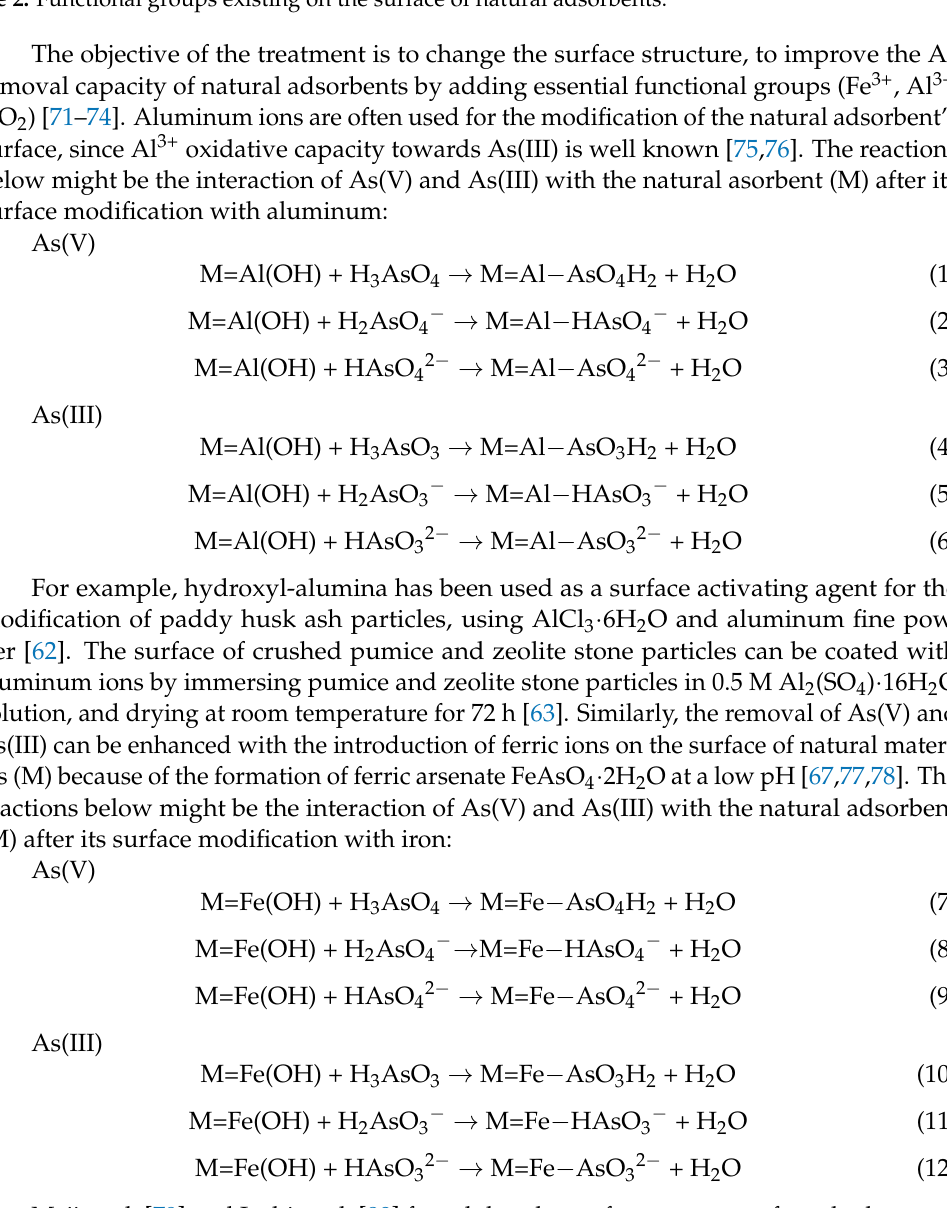
Figure 2. Functional groups existing on the surface of natural